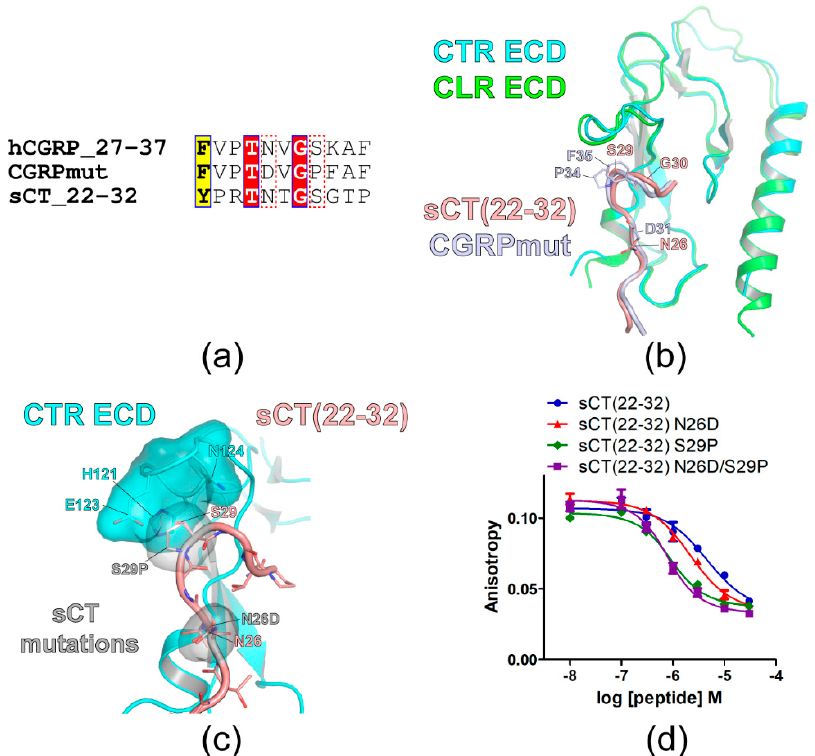
Figure 1. Research strategies for the introduction of sCT mutations and the mutational effects on sCT(22–32) affinity for CTR ECD. ( a ) Sequence alignment of the peptide ligands. The sequence of human α -CGRP (hCGRP) was used for hCGRP_27–37 where the number indicates the amino acid number. CGRPmut was the hCGRP_27–37 fragment with N31D, S34P, and K35F mutations. The amino acid sequence of sCT(22–32) was also shown. A similar residue was shown in black bold characters and boxed in yellow. Identical residues were shown in white bold characters and boxed in red. N31 and S34 of hCGRP_27–37 and corresponding residues of CGRPmut and sCT_22–32 were boxed with a red dotted line. ( b ) Crystal structures of CTR ECD with sCT(16–32) (PDB 6PFO, Mol A) and CLR ECD (PDB 4RWG) with CGRPmut were aligned. sCT(16–21) structure was omitted and only sCT(22–32) structure was shown. ( c ) The hypothetical structure of CTR ECD with sCT(22–32) with mutations. sCT N26D and S29P mutations were introduced and the mutated residues were superimposed with sCT wild-type residues. CTR ECD H121, E123, and N124 and sCT N26D and S29P mutated residues were shown both with stick and surface representations. ( d ) FP competition peptide binding assay with sCT(22–32) with mutations and purified CTR ECD. FITC-sCT(22–32) was used as a peptide probe. Representative peptide-binding curves were shown from three independent experiments.